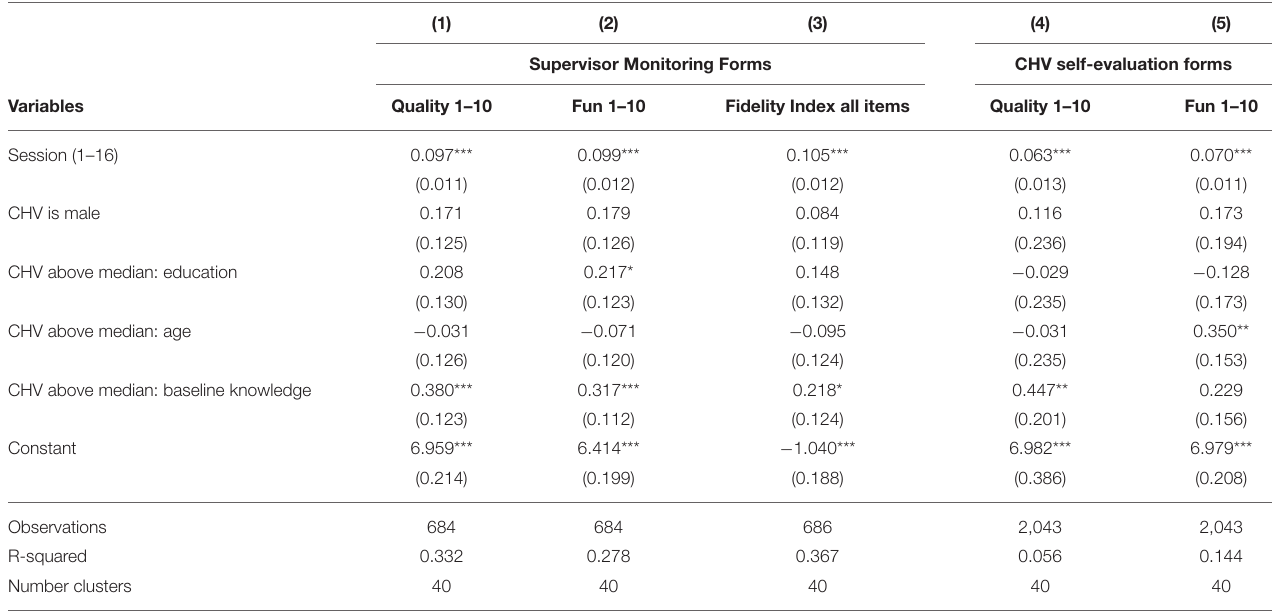
TABLE 3 | Determinants of delivery fidelity, supervisor, and self